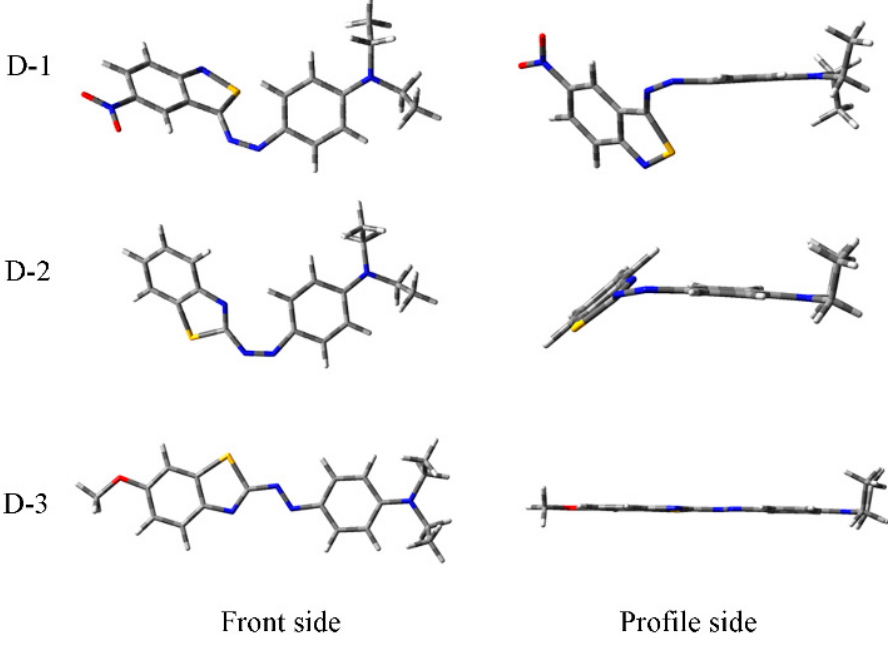
Figure 6. Optimized structure for the chromophore in reactive dyes.